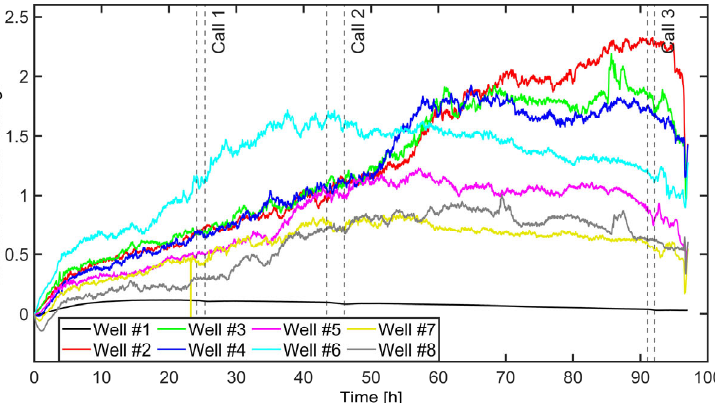
Figure 9. Results of normalized impedance measurements for the signal with f = 16 kHz, measured during 93 h of cell culture.